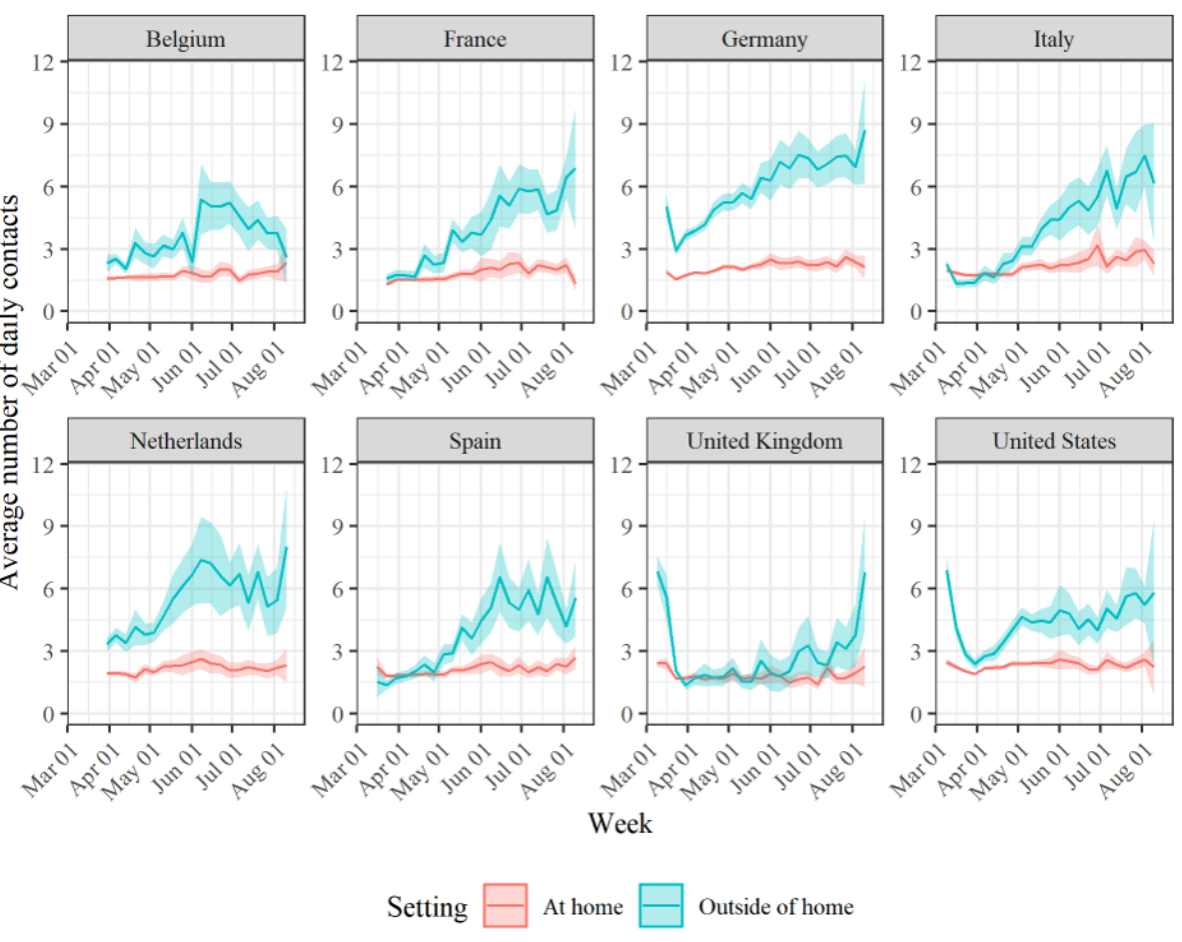
Figure 2. Average number of contacts at home and outside of home per week between March 13 and August 12, 2020 across the 8 countries. Lines show averages and shaded areas show 95% confidence intervals. Poststratification weighting has been